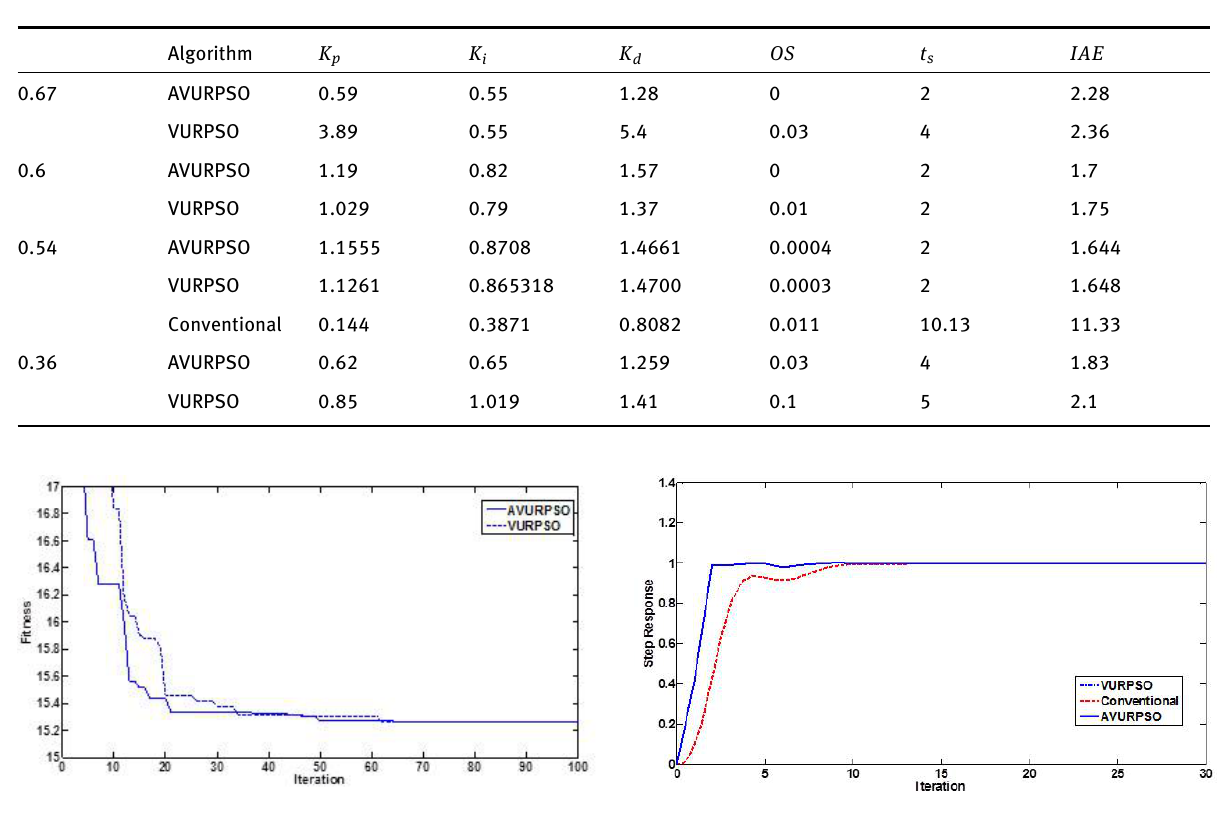
Table 1: A comparison between algorithms on performance of the PID controller in Example 1.